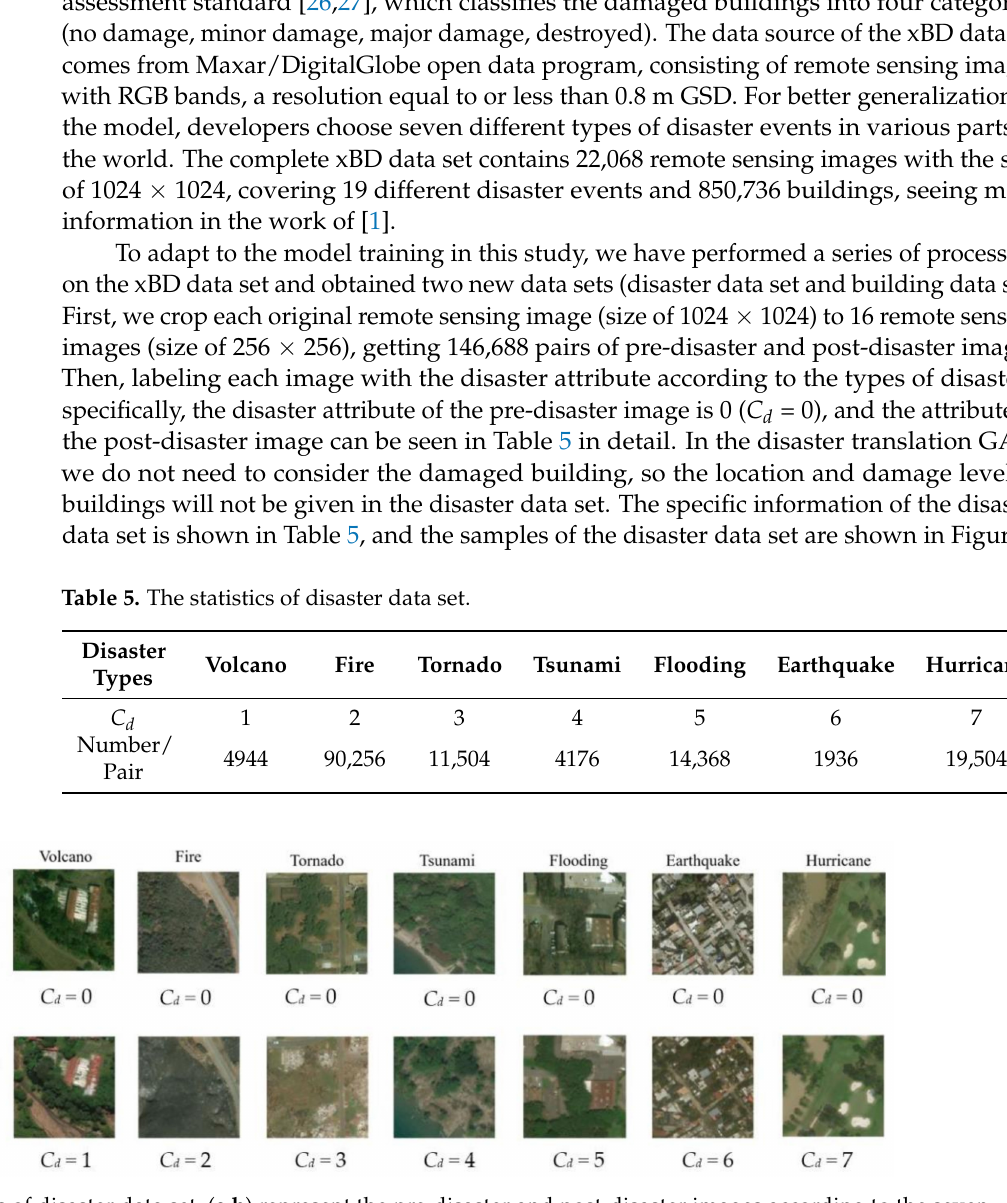
Figure 3. The samples of disaster data set, ( a , b ) represent the pre-disaster and post-disaster images according to the seven types of disaster, respectively, each column is a pair of